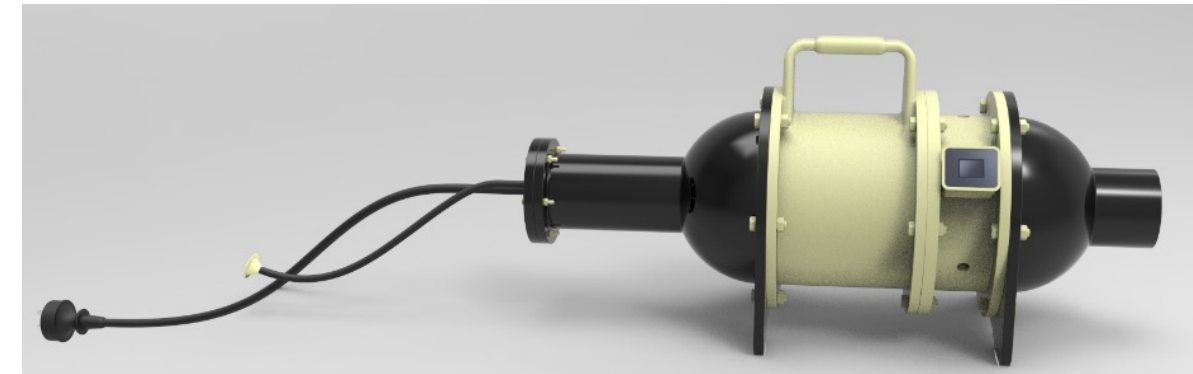
Figure 2. The structure of the nasal cavity with the gas inlet on the left and the exhaust outlet on the right.